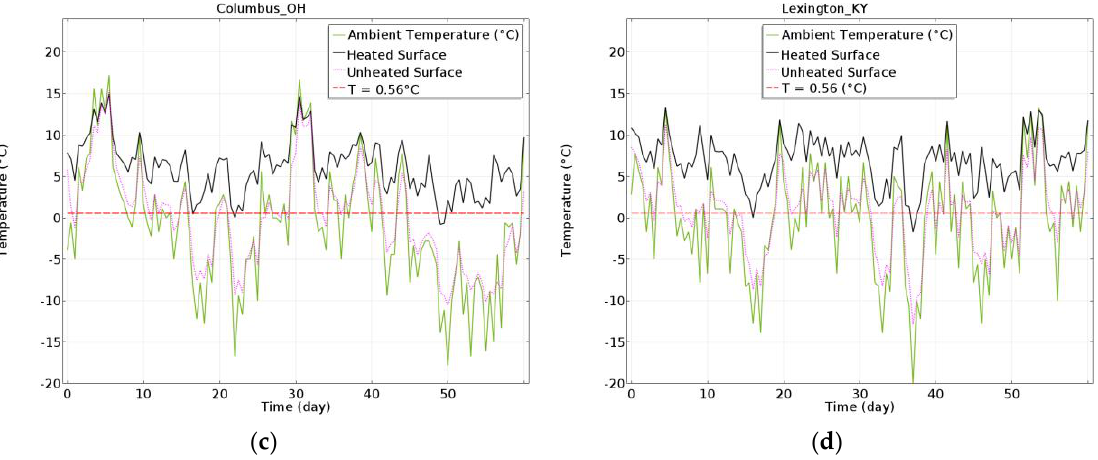
Figure 11. Pavement temperature for six various locations: ( a ) Amarillo, TX; ( b ) Baltimore, MD; ( c ) Columbus, OH; and ( d ) Lexington, KY.